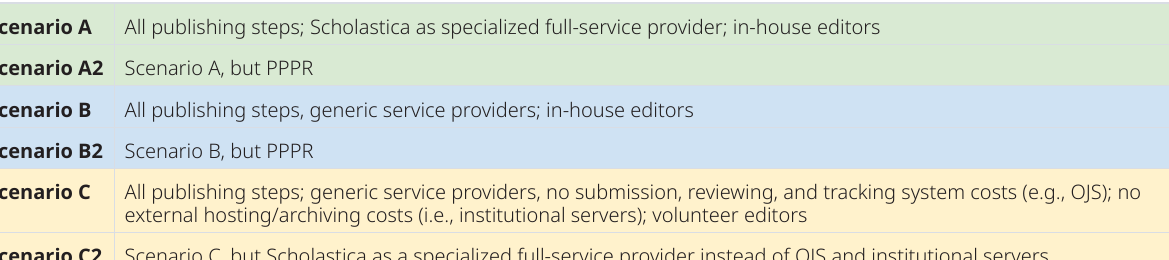
Table 3. Publishing scenarios for which detailed cost calculations have been performed. PPPR - post publication peer- review (i.e., no rejections after peer-review). OJS - Open Journal System Scenario